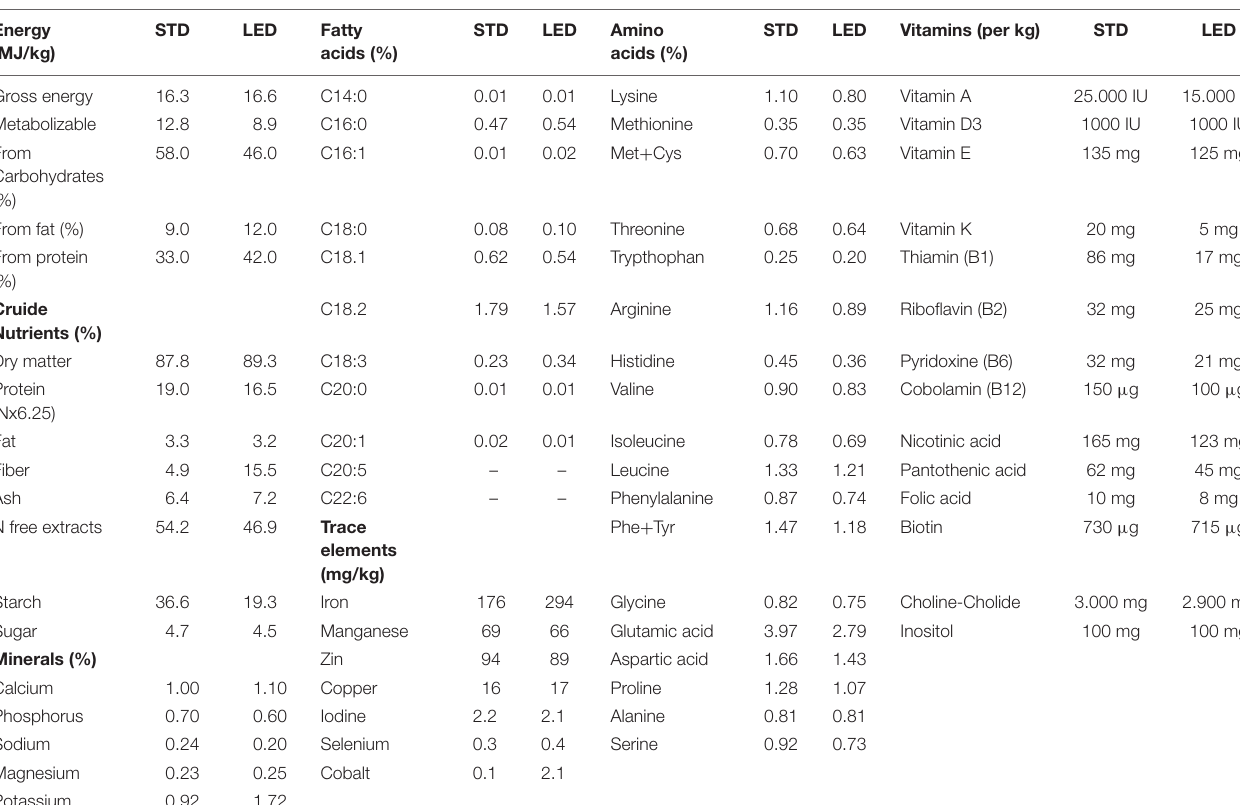
TABLE 2 | Composition of the standard diet (STD) and the low energy diet (LED) according to the informations provided by the manufacturer. Energy